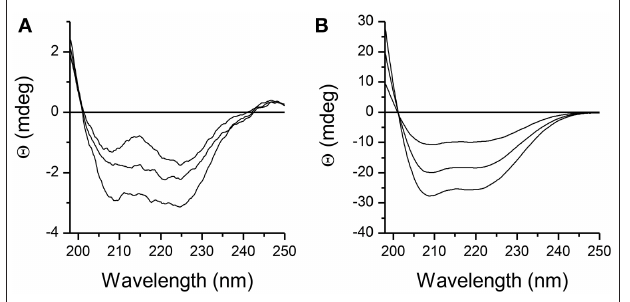
FIGURE 2 | CD spectra of the peptide DP cpvtN2 . (A) 1.5, 2.0, and 3.0 µ M solution of DP cpvtN2 in phosphate buffer, pH 7.0. (B) 1.5, 2.0, and 3.0 µ M solution of DP cpvtN2 in